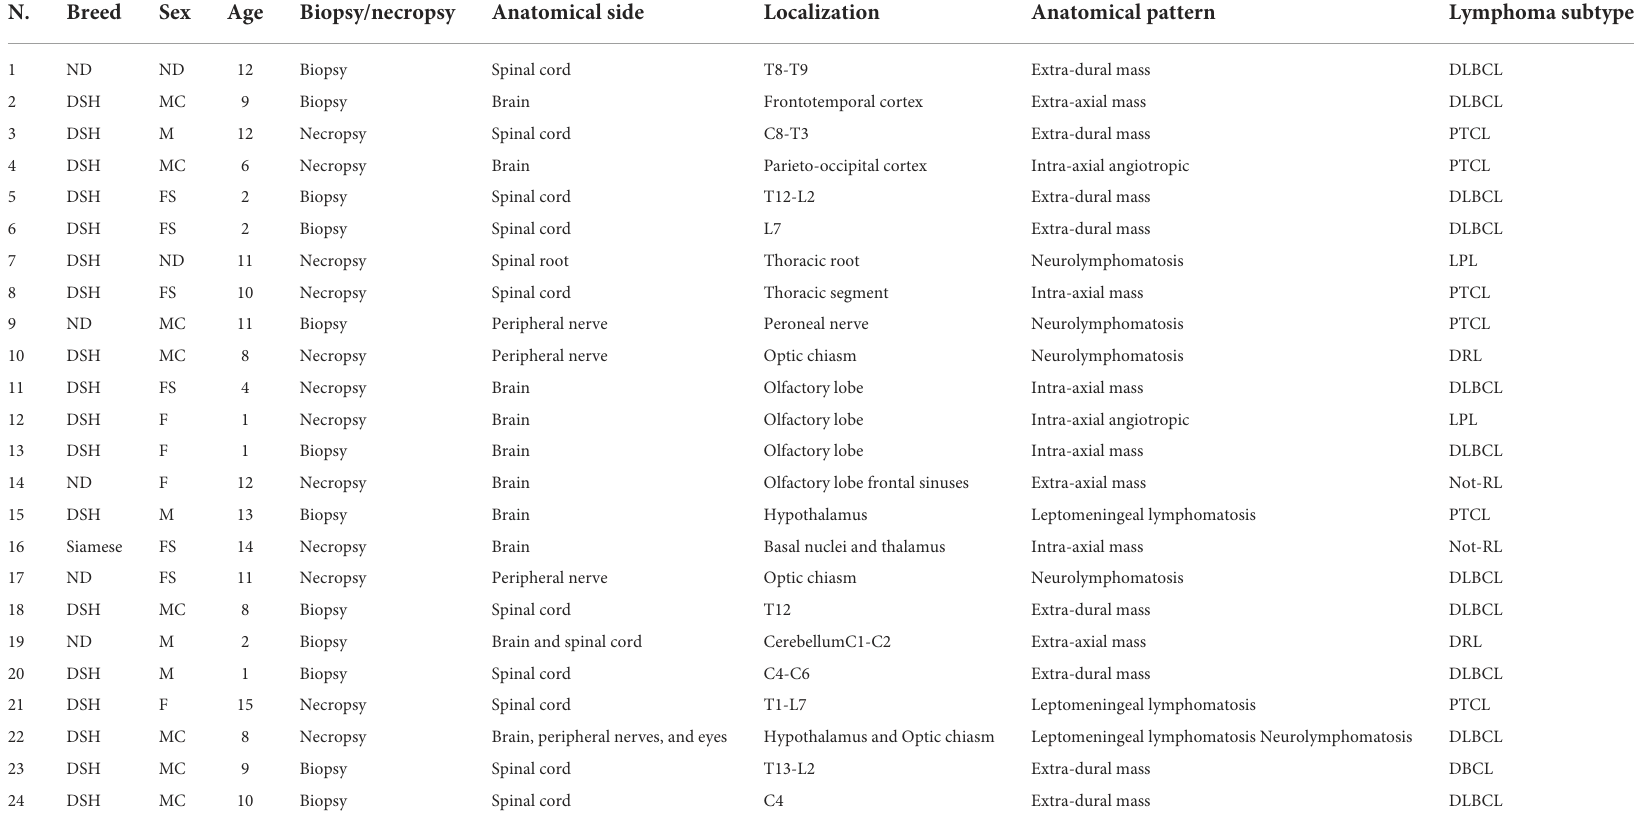
TABLE 1 Signalment data, anatomical details of tumors, and lymphoma subtypes.